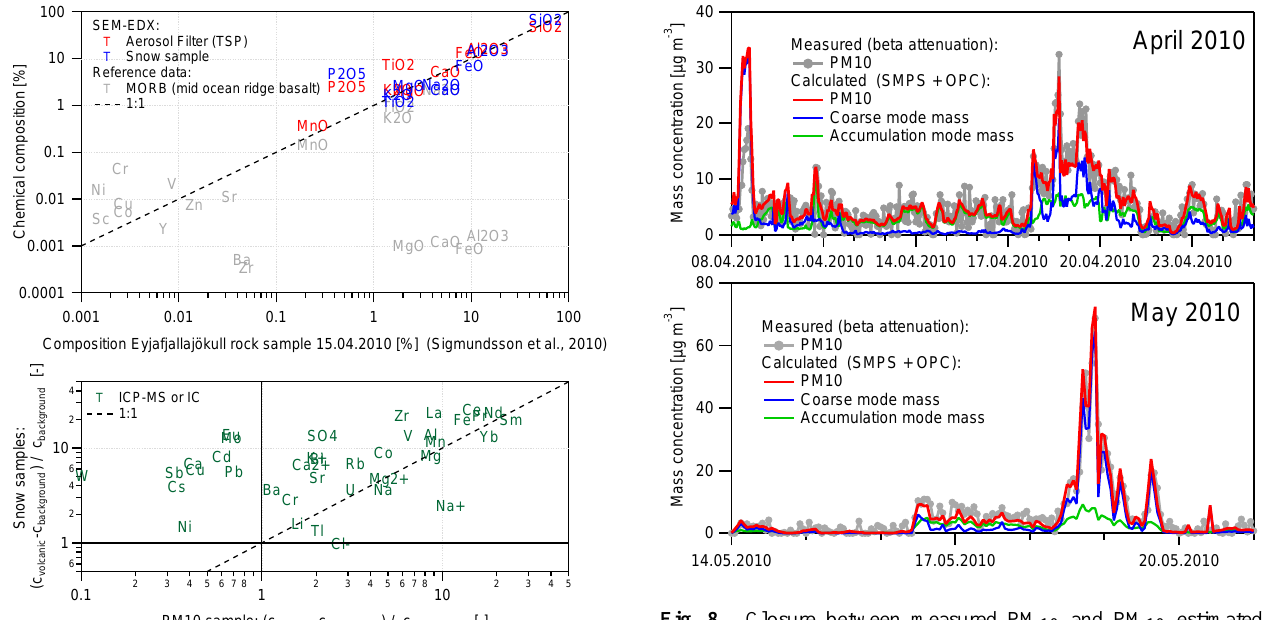
Fig. 8. Closure between measured PM 10 and PM 10 estimated from the measured number size distributions (10nm to 20µm, mea- sured by SMPS and OPC). A refractive index of 1.54+0.005i ( λ = 780nm) was used to correct the OPC volume distributions, which subsequently were integrated (together with the SMPS dis- tributions) to PM 10 mass concentrations assuming densities of 1.6gcm − 3 for the accumulation mode (optical diameter < 0.8µm) and 2.65gcm − 3 for the coarse mode (optical diameter > 0.8µm), respectively. The uncertainty in the beta attenuation measurement is ± 1.4µgm − 3